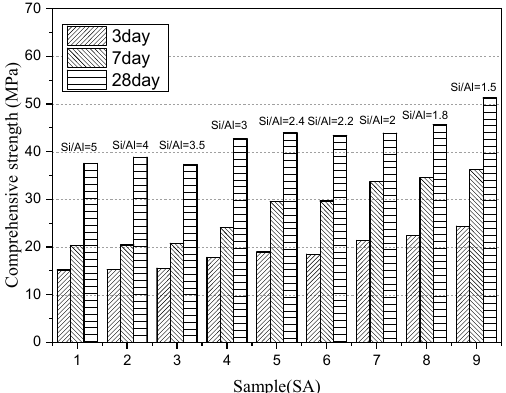
Figure 5. Compressive strength of slag with di ff erent S / A at 3 d, 7 d and 28 d